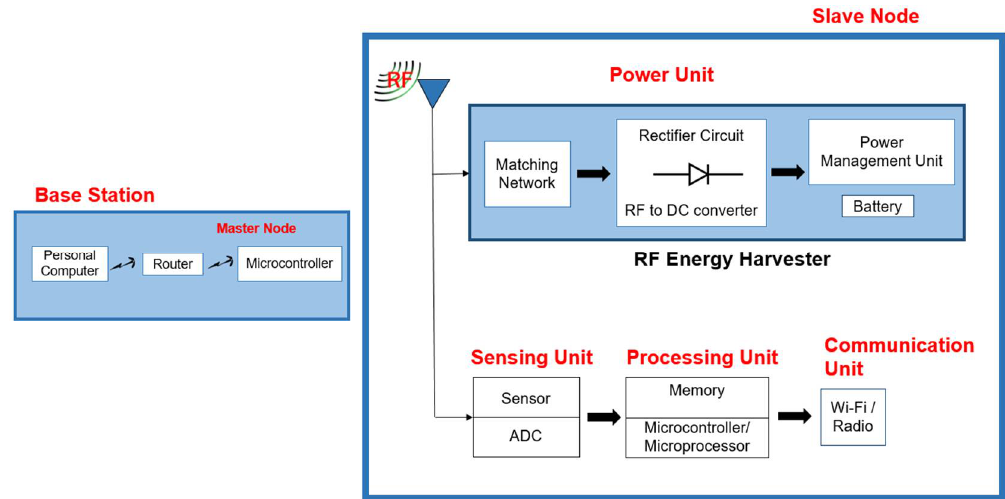
Figure 5. Sensor node